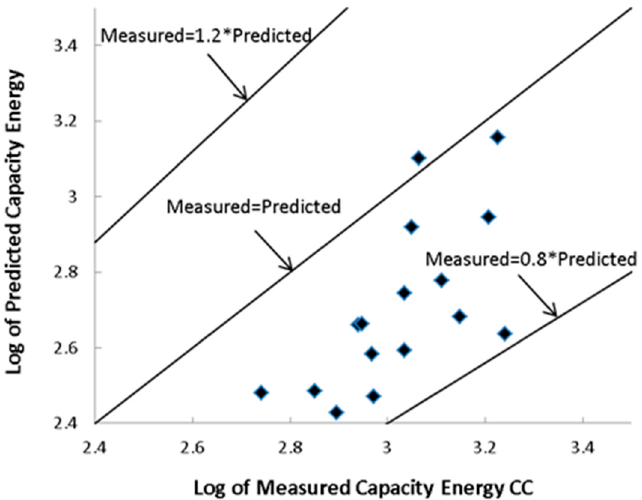
Figure 3. Capacity energy predicted by RSM equation on the basis of the central composite (CC) design of experiment (DOE) and the first ANN model versus the measured values of laboratory tests.